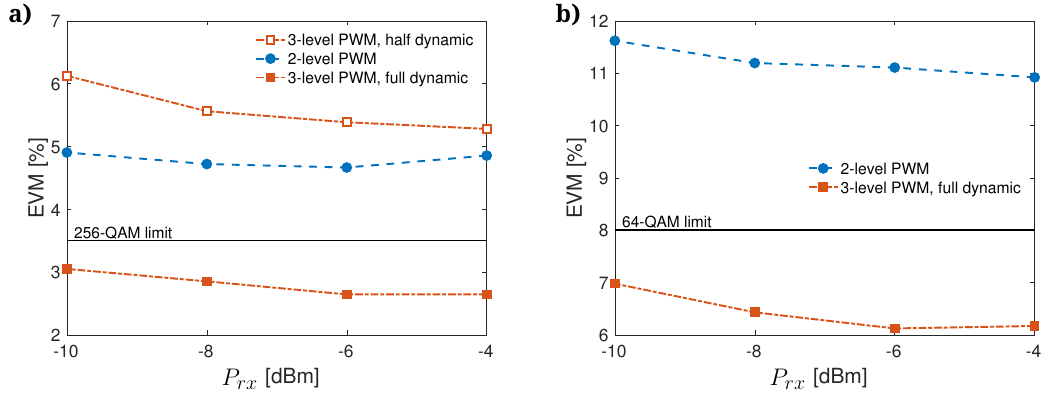
Figure 6. Average percentage EVM against received optical power P rx , N ch = 8 ( a ) and N ch = 16 ( b ) aggregated 20-MHz LTE-like channels,